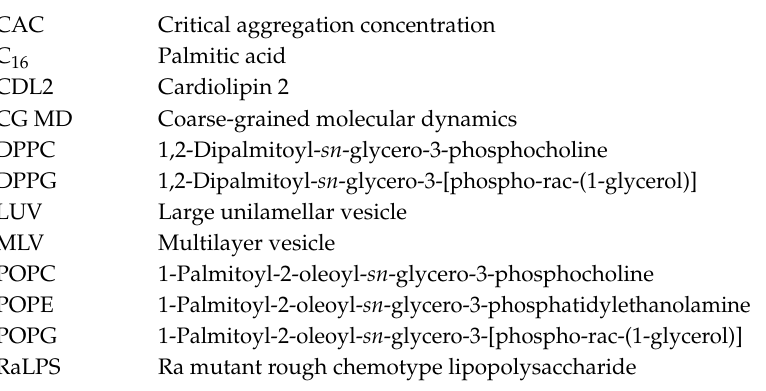
bilayer systems, Table S3: The average and standard deviation of the APL and bilayer thickness over the last 100 ns of the CG MD simulations, Figure S1: Chemical structures of L-lysine and its shorter homologues used in this study. Figure S2: Fluorescence images of S. epidermidis viability staining, planktonic cell stained with SYTO9, PI, and PI + SYTO9 treated with KK(K C16 )KK-NH 2 up to concentration of 8, 16, and 32 µ g / mL, corresponding to 1 × MIC, 2 × MIC, and 4 × MIC, respectively, negative and positive controls. Green color indicates the bacterial cells with intact membranes, whereas red color indicates the bacterial cells with damaged membranes. Figure S3: ( A ) Log CAC vs. the number of lysine residues for the N -palmitoylated lysine-based peptides, based on the data from reference [22]; ( B ) Log CAC vs. the number of methylene groups in the side chain of palmitoylated residue (from Dap to Lys); ( C , D ) Self-di ff usion coe ffi cients vs. lipopeptide concentrations for penta- and tripeptides. Arrows indicate two breakpoints for K(O C16 )K-NH 2 analogue, relating to the premicellar and micellar states, Figure S4: Isothermal titration of 1.3 mM POPG to ( A ) 0.05 mM KK(K C16 )KK-NH 2 ; ( B ) 0.05 mM KK(O C16 )KK-NH 2 ; ( C ) 0.05 mM KK(Dab C16 )KK-NH 2 ; ( D ) 0.05 mM KK(Dap C16 )KK-NH 2 at 298 K. The lower curves represent the heat of reaction (measured by peak integration) vs. the lipid / lipopeptide molar ratio, Figure S5: